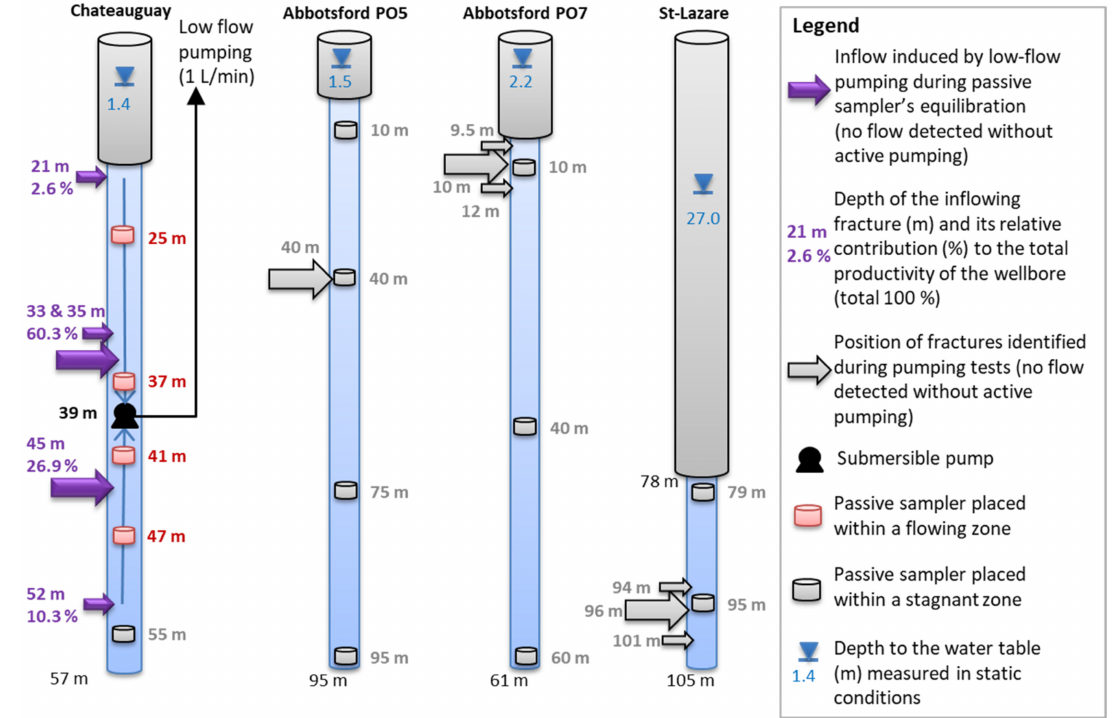
Figure 6. Placement of passive samplers for wells having stagnant water column in static condition. Flows for Chateauguay were imposed by a permanent low flow pumping at a depth of 39 m in order to constrain water flows during passive sampler’s